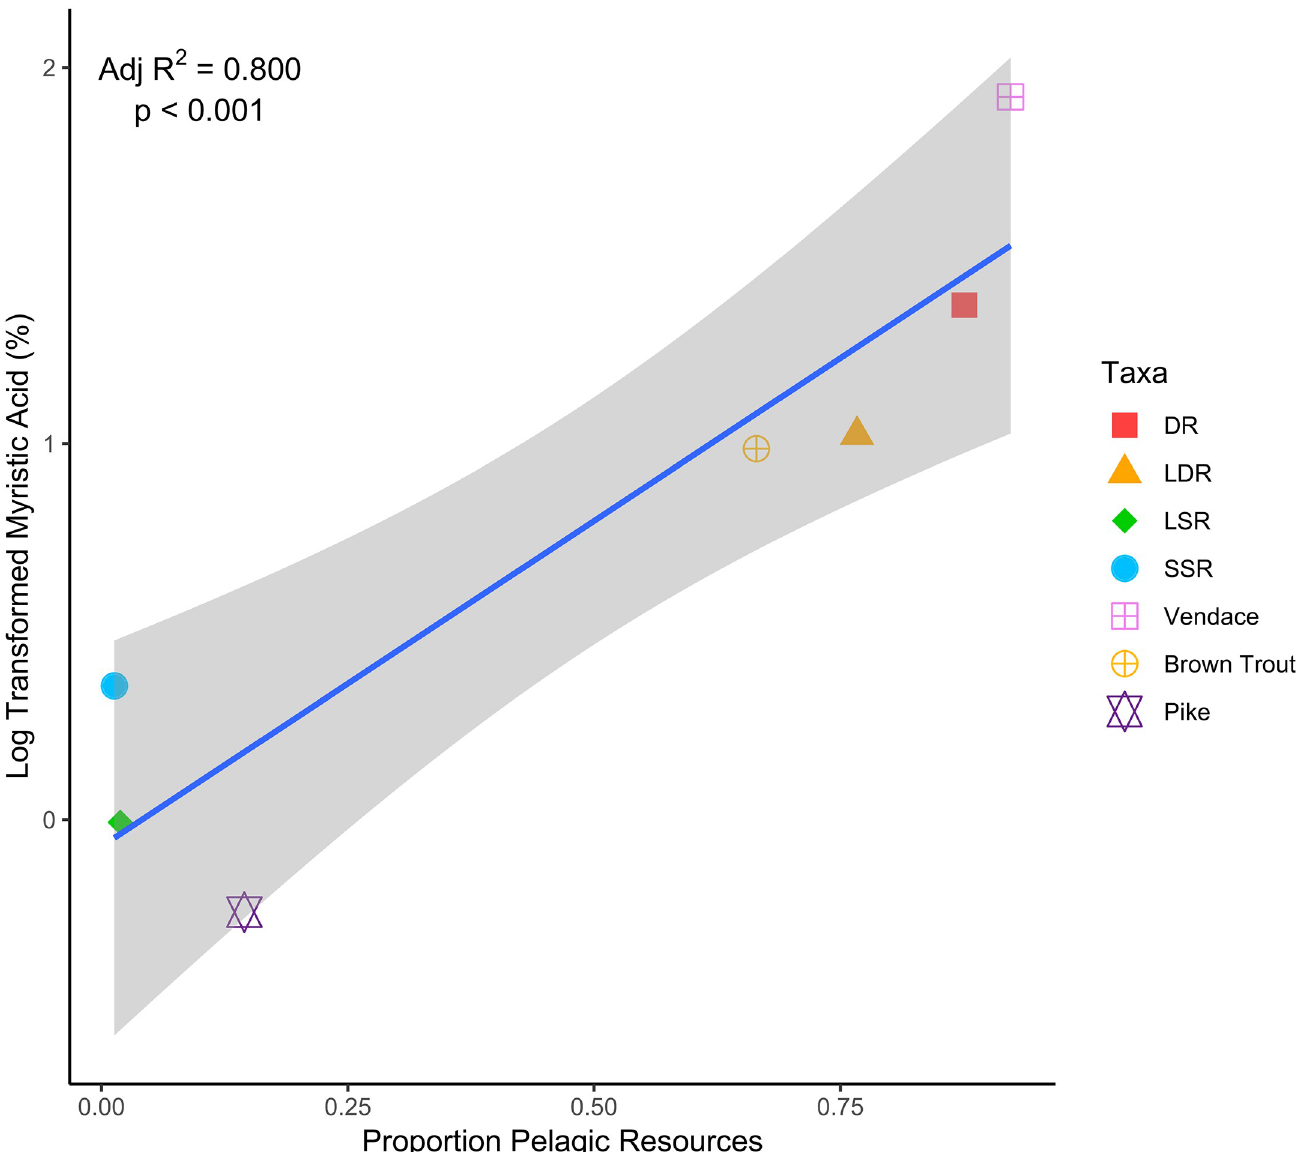
Fig 5. Relationship between log-transformed myristic acid concentration (%) and mean pelagic reliance (estimated from SIAR model based on δ 13 C, δ 15 N and diet data) across all fish taxa. DR = densely-rakered whitefish, LDR = large densely-rakered whitefish, LSR = large sparsely-rakered whitefish, SSR = small sparsely-rakered